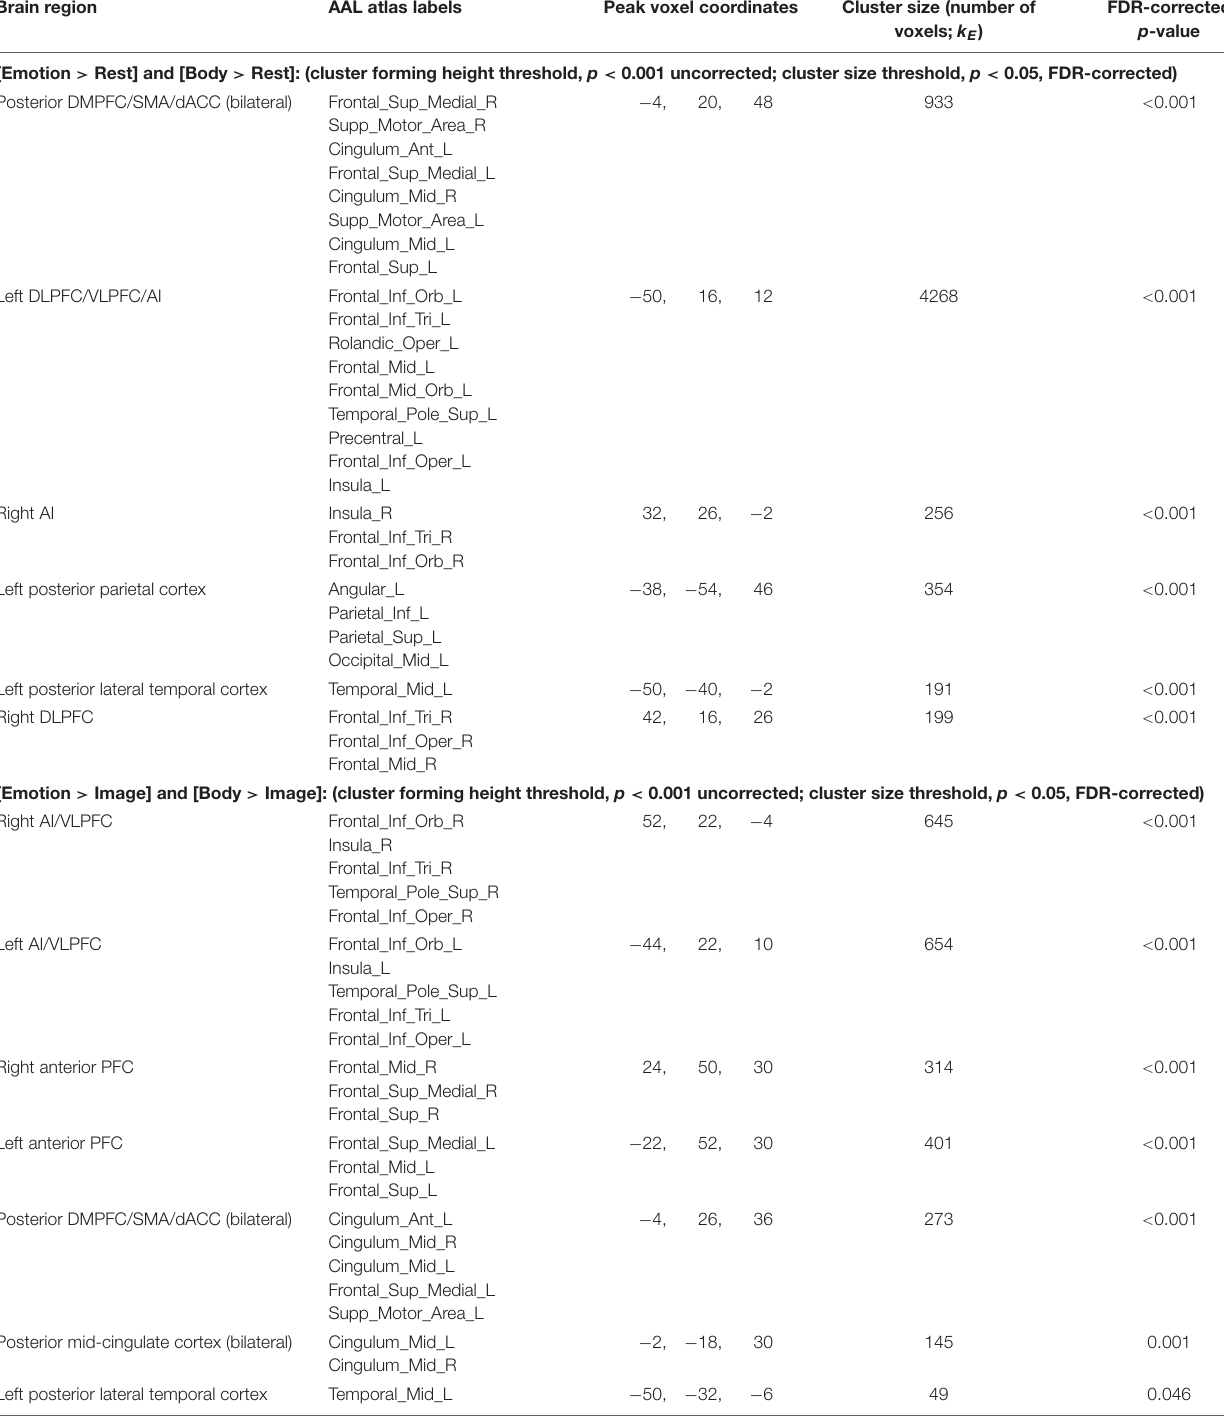
TABLE 4 | fMRI results: conjunction analyses. Brain region AAL atlas labels Peak voxel coordinates Cluster size (number of